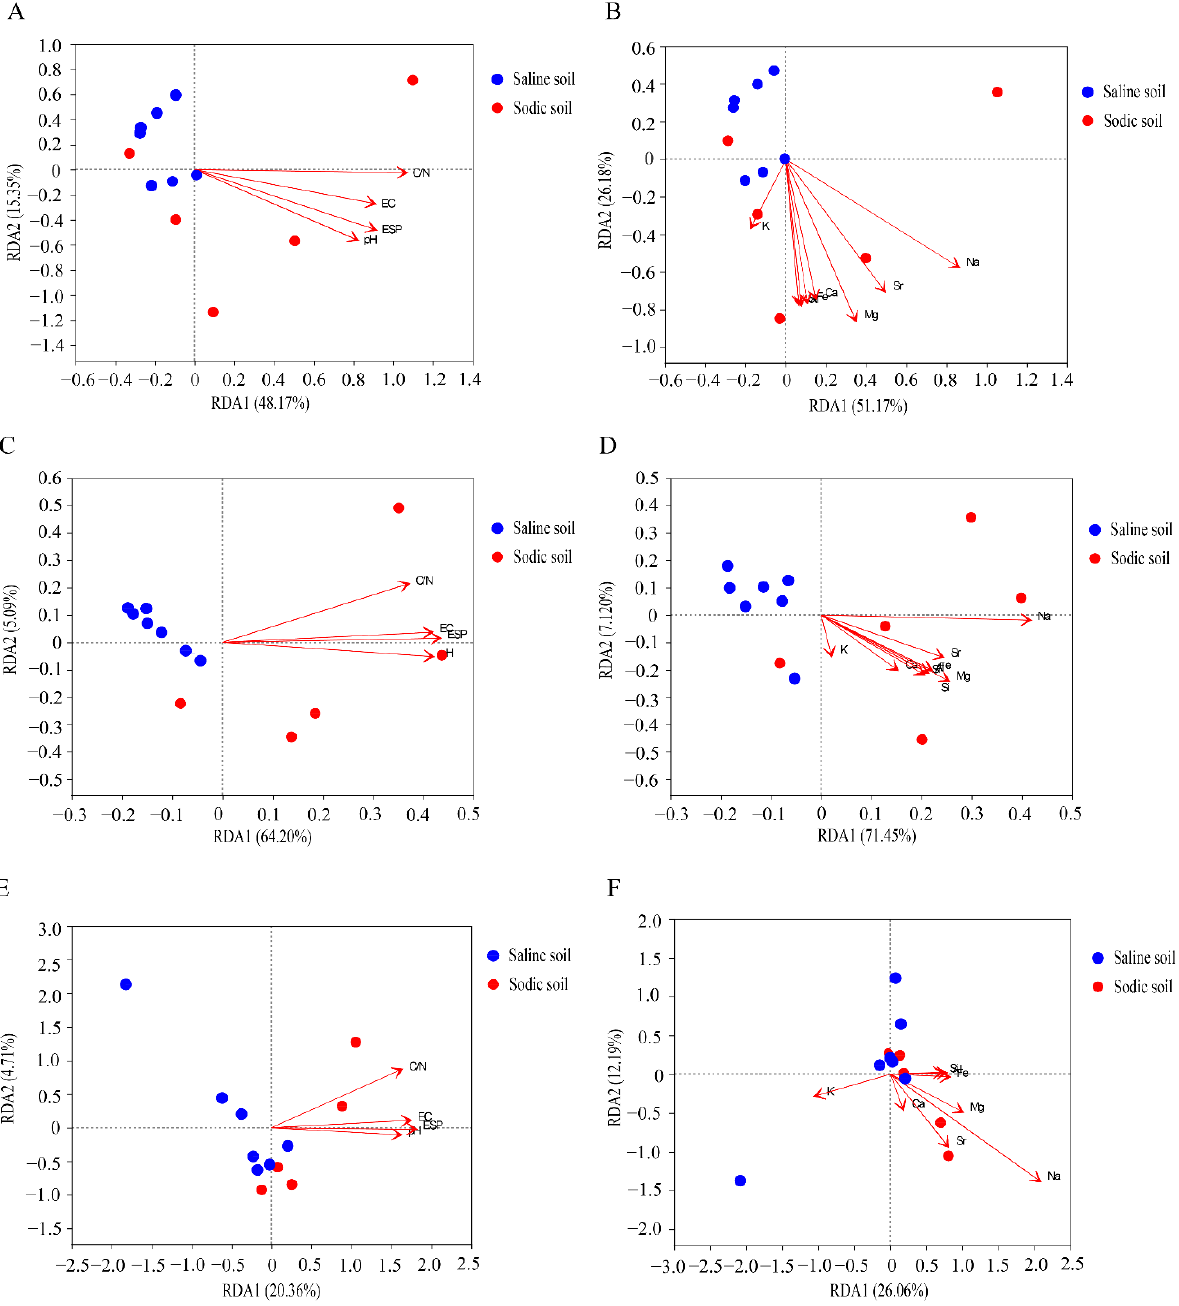
Figure 3. The relationship between basic physicochemical properties and soil metal elements in sa- line and sodic soil samples and archaeal ( A and B ), bacterial ( C and D ), and fungal ( E and F ) com-